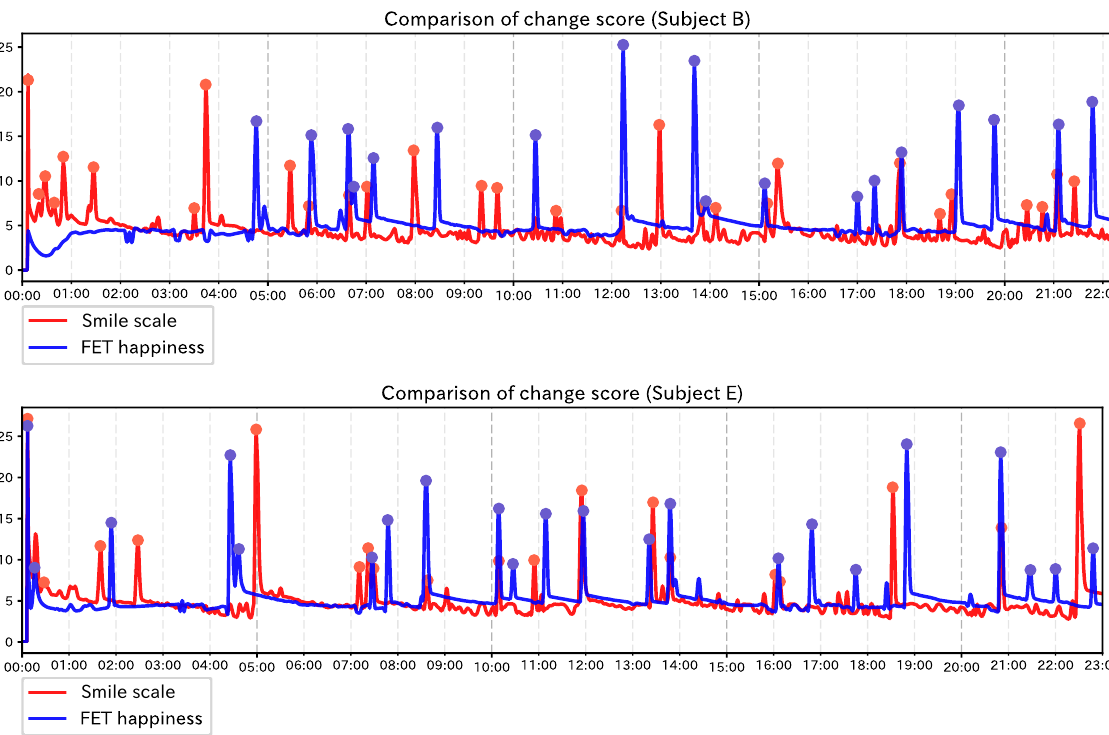
Figure 14. Graphs of the change score for FET’s “happiness” value (Subject group 2).